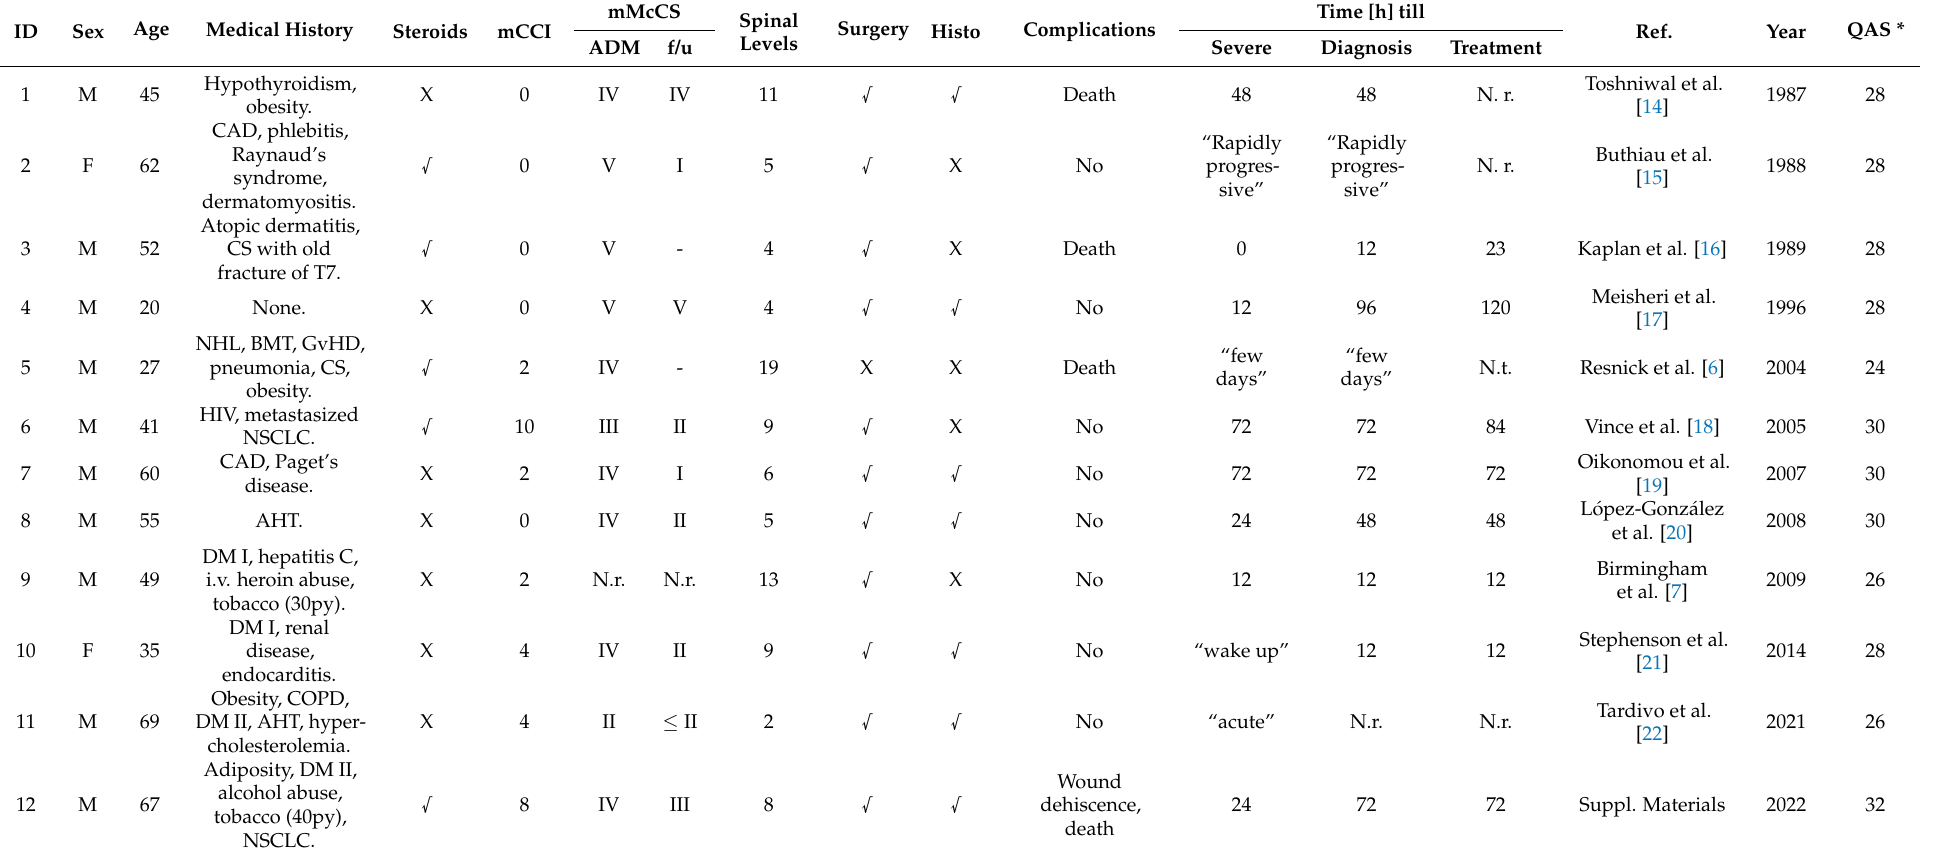
Table 1. Summary of patients with acute, severe SEL, with the first eleven patients representing the cases identified by the systematic literature